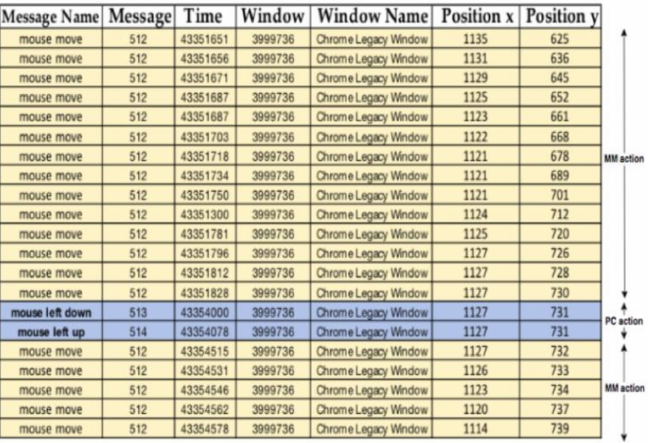
Figure 3. Data collection parameters and mouse data segmentation into actions.